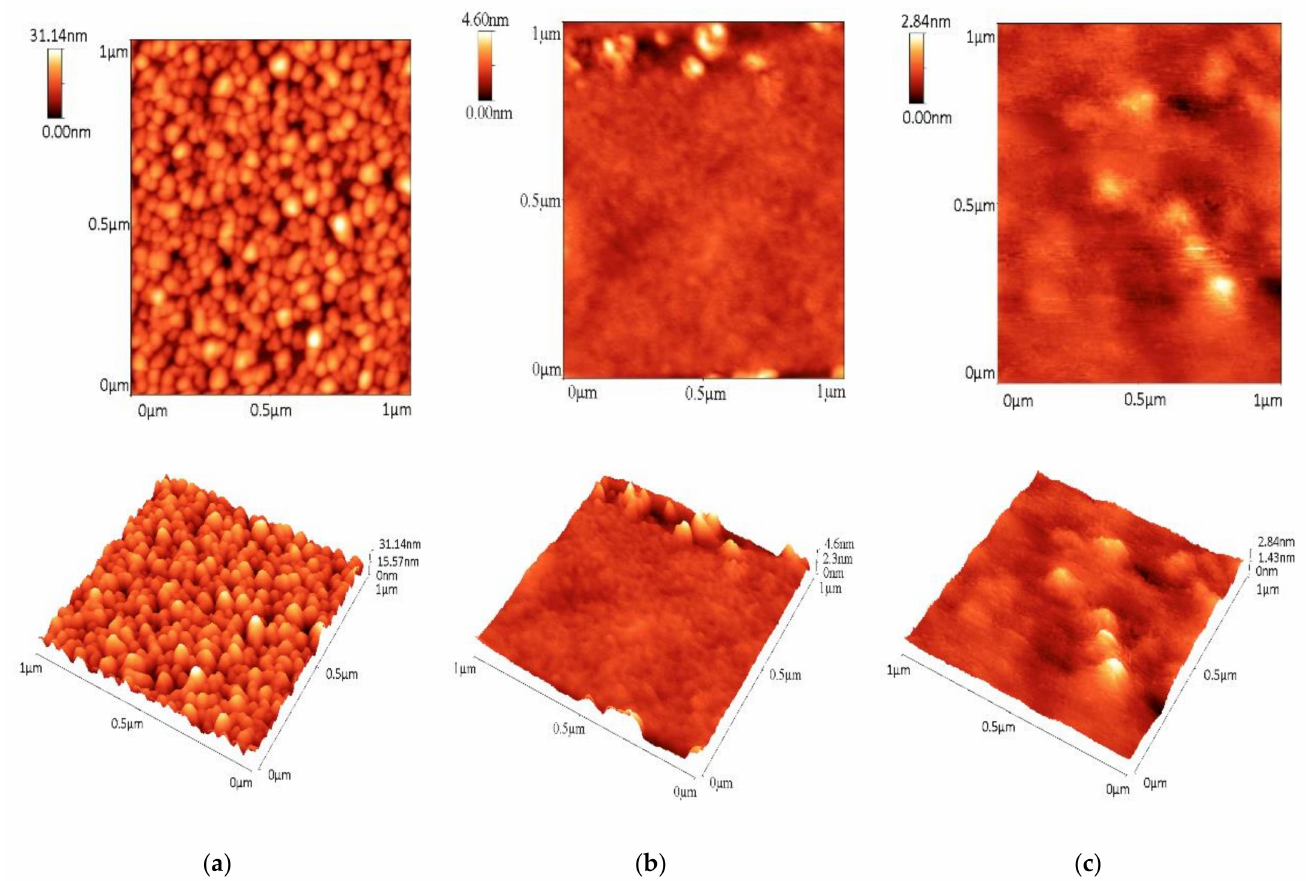
Figure 9. AFM images of Ag DC 100 monolayer ( a ) compared with the bilayers Cu150 Ag100 ( b ) and Cu250 Ag100 ( c